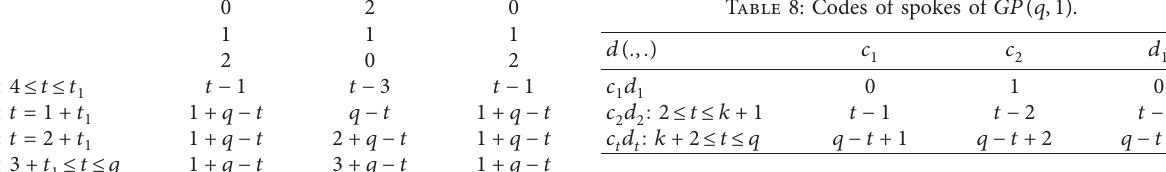
Table 2: Codes of spokes of GP ( q, 1 ) when q is odd. d ( ., . )